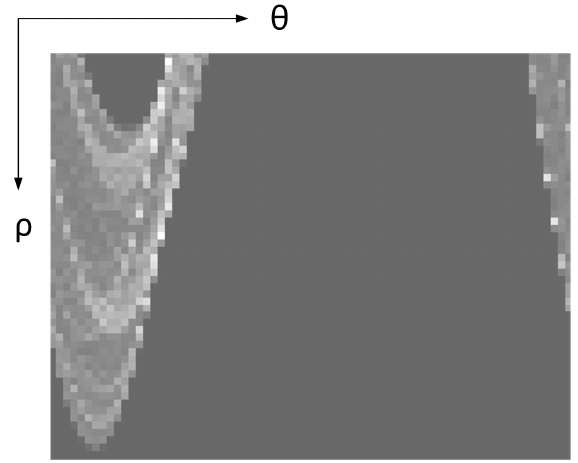
Figure 4. Display of the parameter space ( H ) of the Hough transform. The pixels with the highest intensities have the parameters ( θ , ρ ) of straight lines of the unknown polygon.